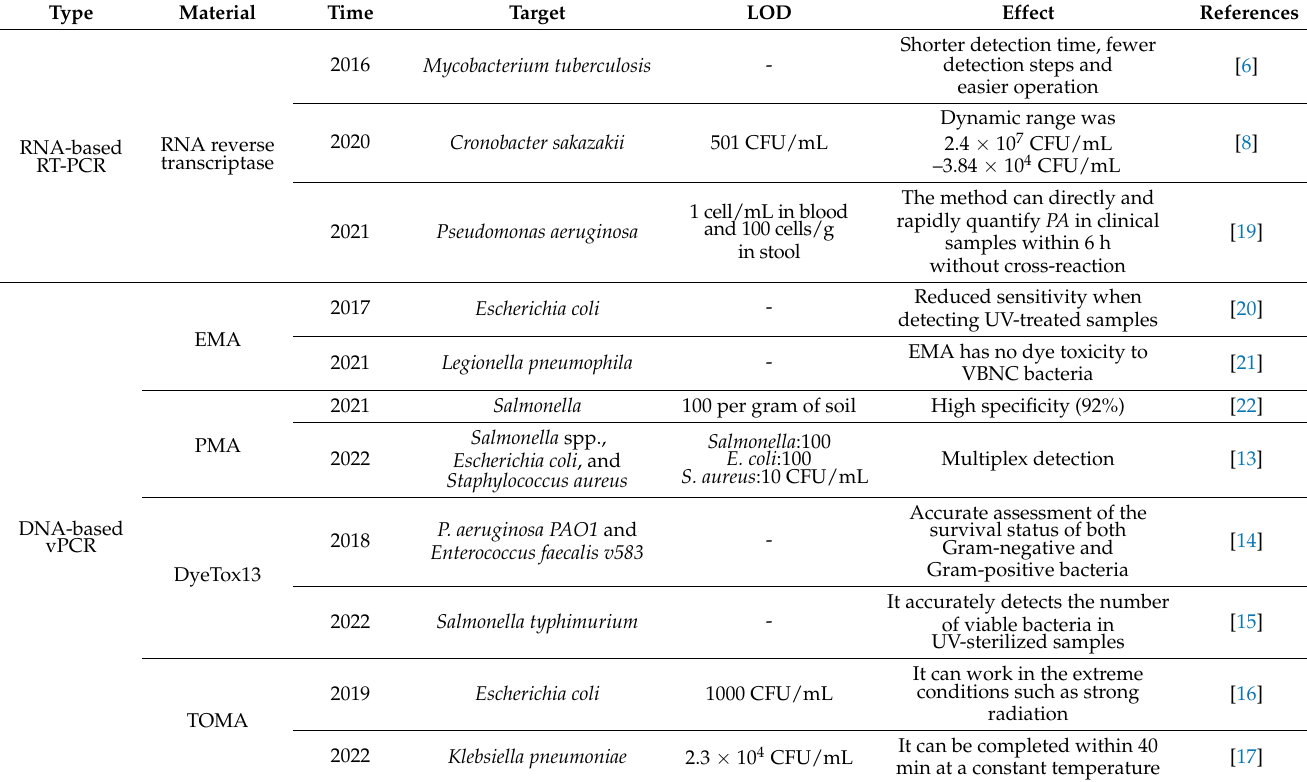
ples(Table 1). Table 1. Comparison of different PCR techniques for detecting viable foodborne pathogens.